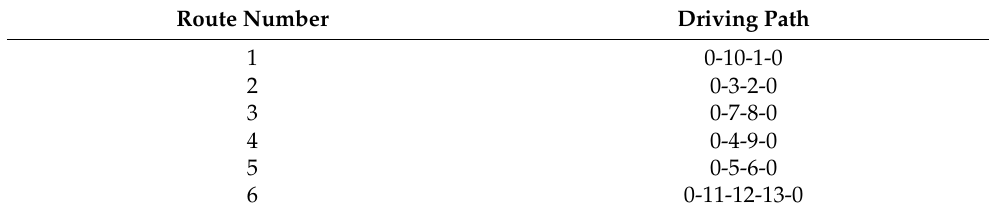
Table 10. Distribution path table before optimization.